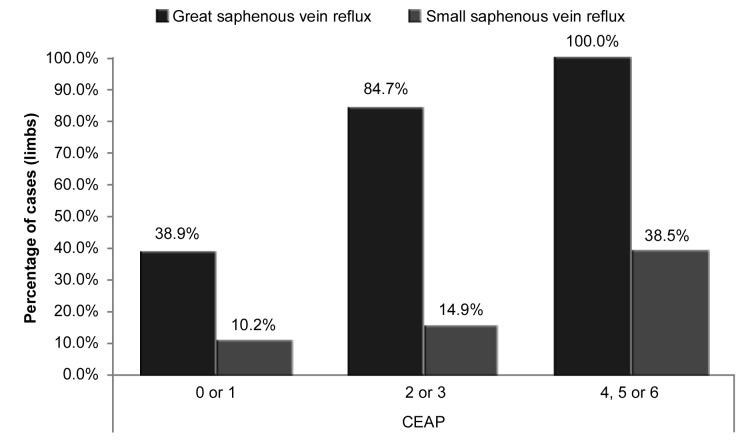
Incidence of reflux in the saphenous veins, by clinical classification.